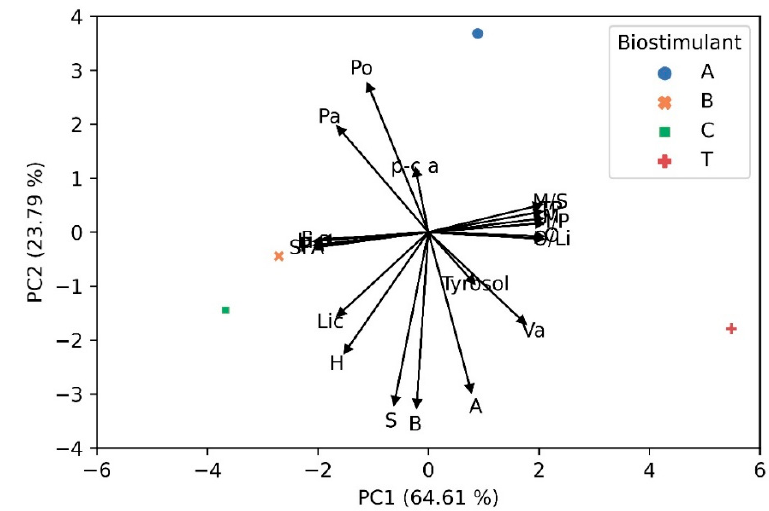
Figure 4. Principal component analysis (PCA) of oil parameters: linolenic (Lic), PUFA (P), SFA, linoleic (Li), ferulic acid (Fa), behenic (B), stearic (S), heptadecanoic (H), p-coumaric acid (p-c a), palmitic (Pa), palmitoleic (Po), arachidic (A), vanillic acid (Va), tyrosol, oleic acid, oleic/linoleic (O/Li), MUFA (M), MUFA/SFA (M/S), MUFA/PUFA (M/P), total polyphenols (TP). C = control, T = trichoderma, B = glycine betaine, A = tropical plants